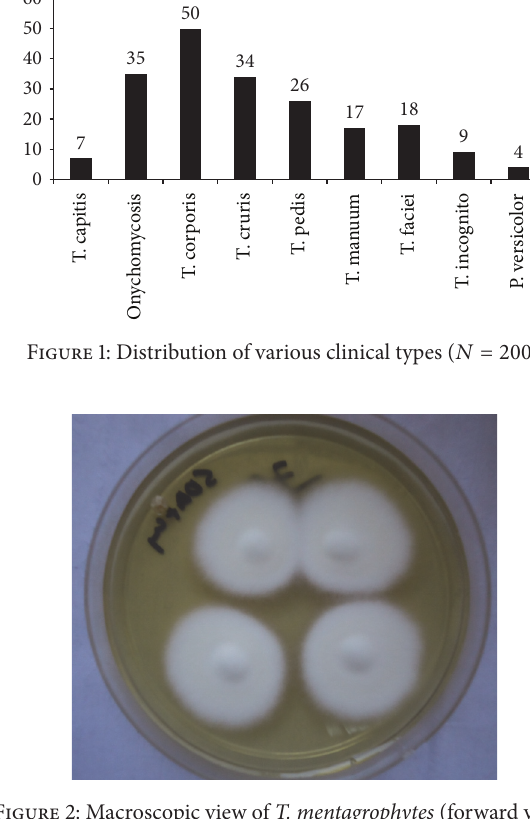
Figure 2: Macroscopic view of T. mentagrophytes (forward